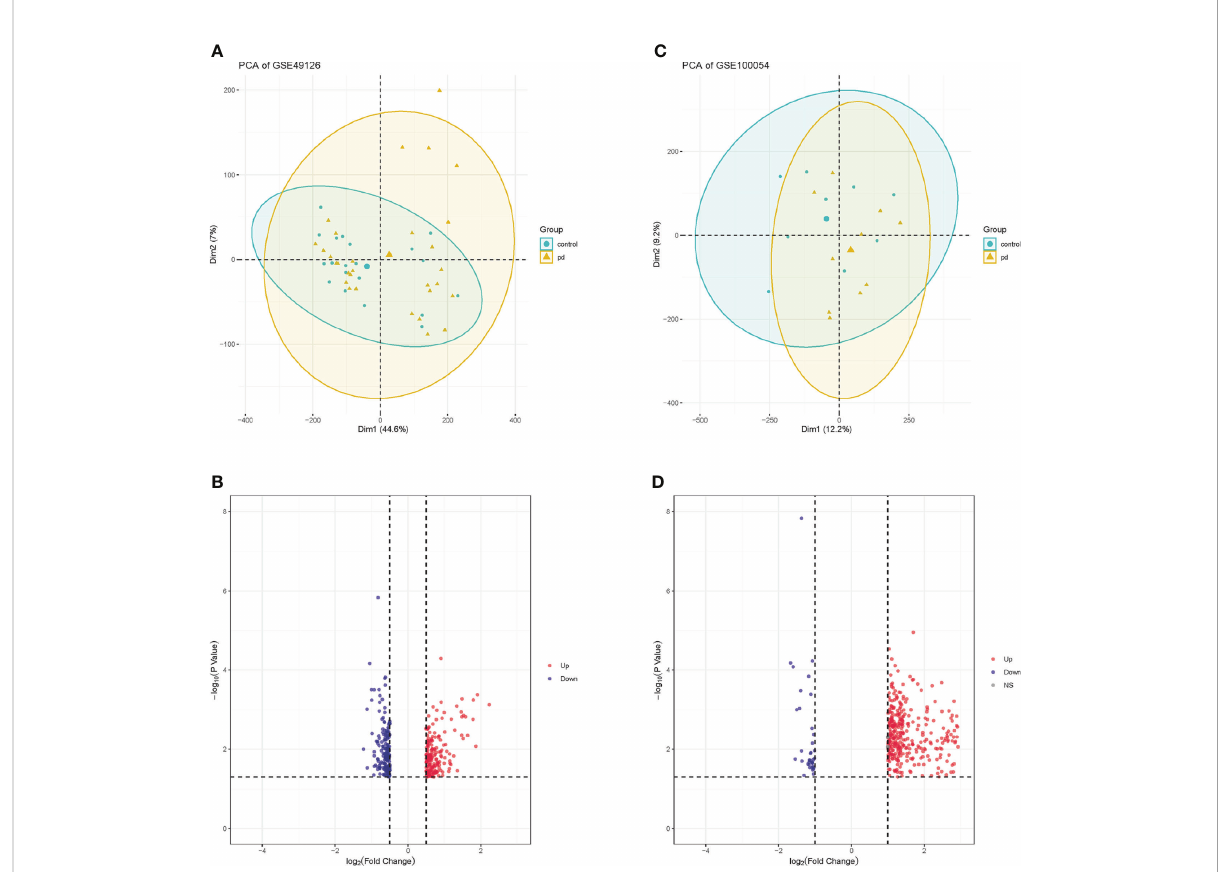
FIGURE 2 PCA plots of gene chips and volcano maps of different expression genes. (A) PCA analysis plot of GSE100054 gene chip; (B) Volcano map of GSE100054 gene chip; (C) PCA analysis plot of GSE49126 gene chip; (D) Volcano map of GSE49126 gene chip. Control represents healthy controls, pd represents Parkinson ’ s disease. Up represents upregulated genes, and down represents downregulated